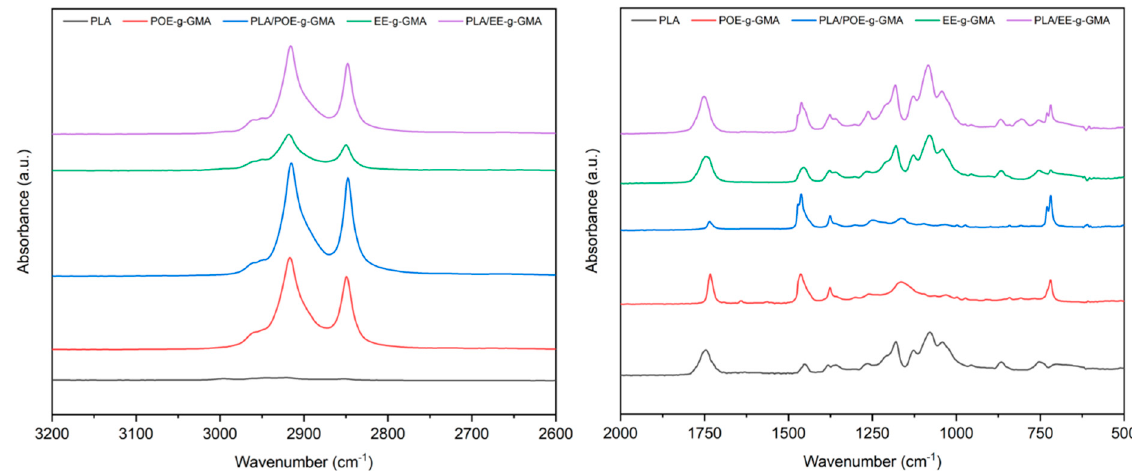
Figure 4. Infrared spectra of pure PLA, EE-g-GMA, POE-g-GMA and the blends (70/30%).